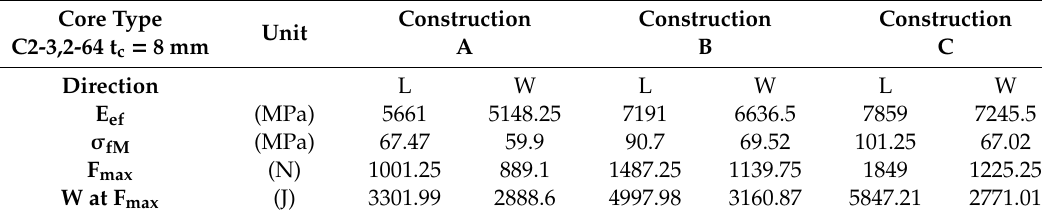
Table 3. Three-point bending